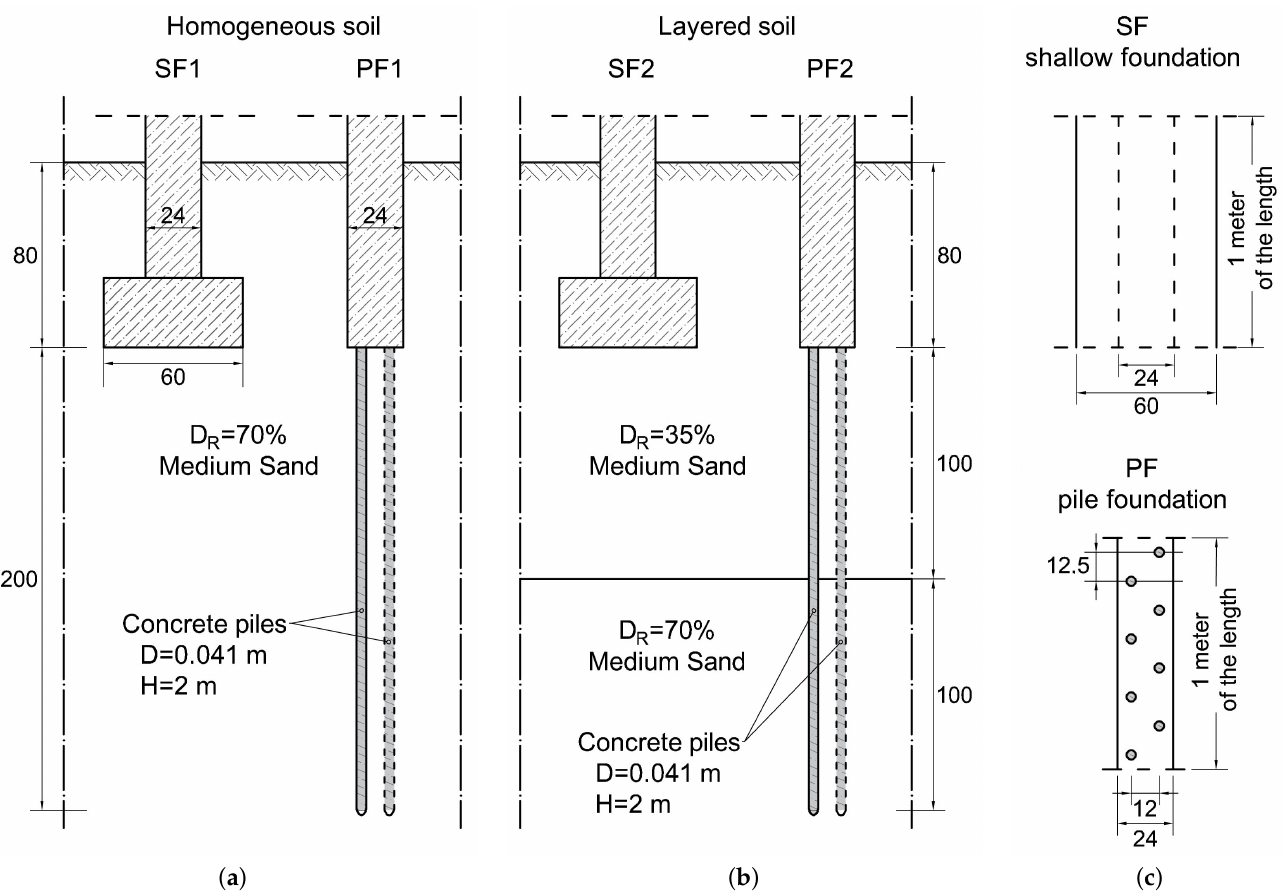
Figure 18. Schemes of foundations and geotechnical profiles: ( a ) Shallow (SF1) and pile (PF1) foundation in homogeneous soil, ( b ) Shallow (SF2) and pile (PF2) foundation in layered soil, annd ( c ) top view of 1 m length of the both foundations. Dimensions in